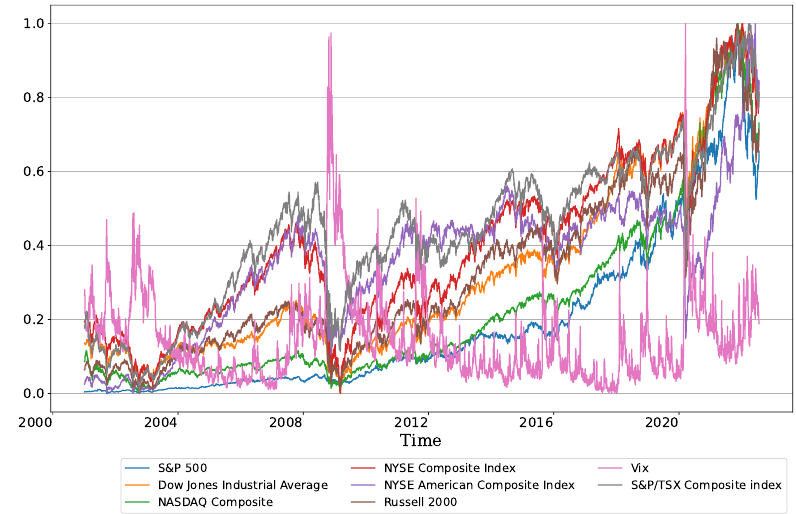
Figure A1. Evolutionary dynamics of North American financial market indices.